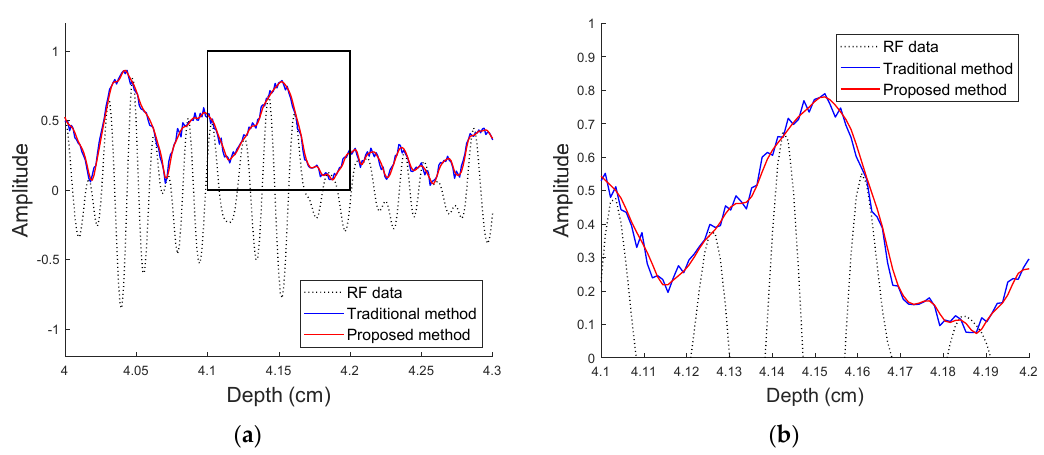
Figure 5. Results of time-domain analysis of compressed sensing (CS) data using the DCT basis matrix: ( a ) Envelope detection for the original signal propagating through the p12 phantom, using the traditional and proposed frameworks for CS data. ( b ) Magnified view of section highlighted in 6(a).